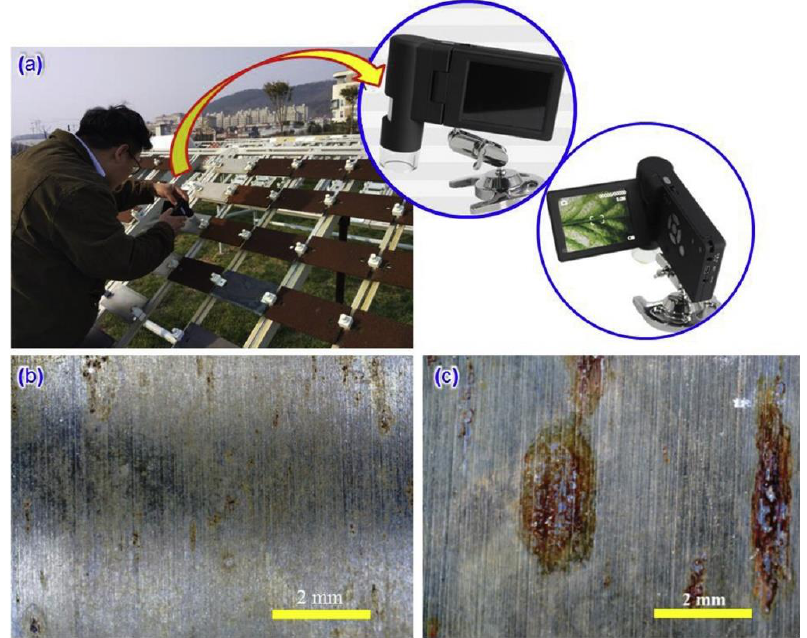
Figure 17. Collection of corrosion images of metallic materials in the field using a portable CCD camera: ( a ) image collection, ( b , c ) corrosion images of 304 SS exposed to a marine atmosphere (reproduced with permission from Reference [153]).